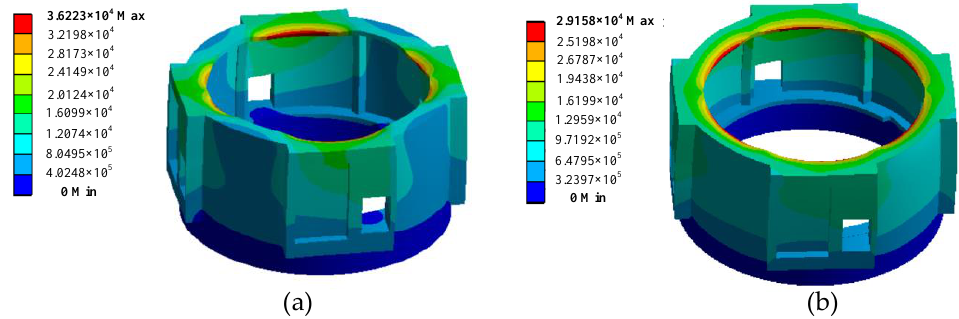
Figure 4. Clamping deformation of cabin section under different clamping strategies. ( a ) Clamping strategy 1; ( b ) clamping strategy 2.